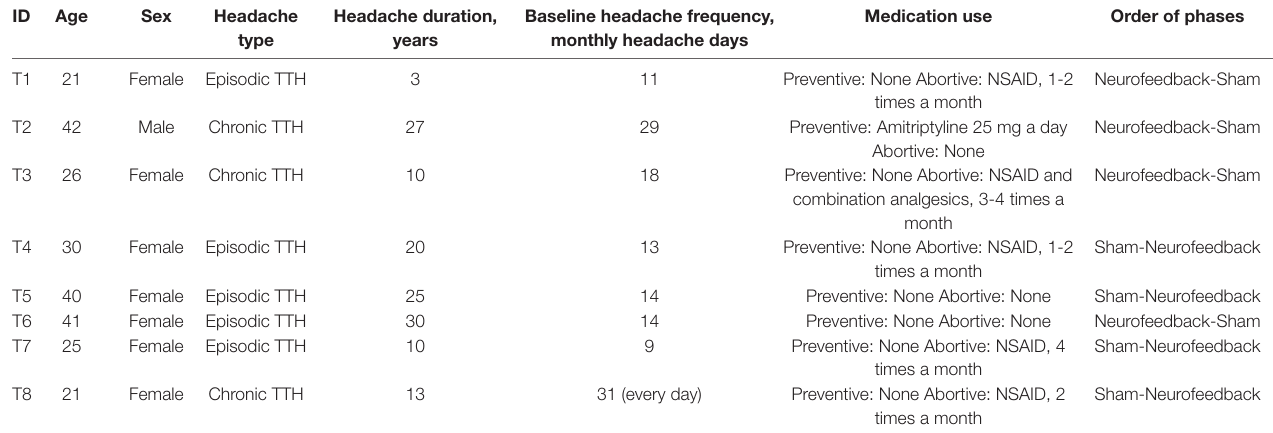
TABLE 1 | Characteristics of the study